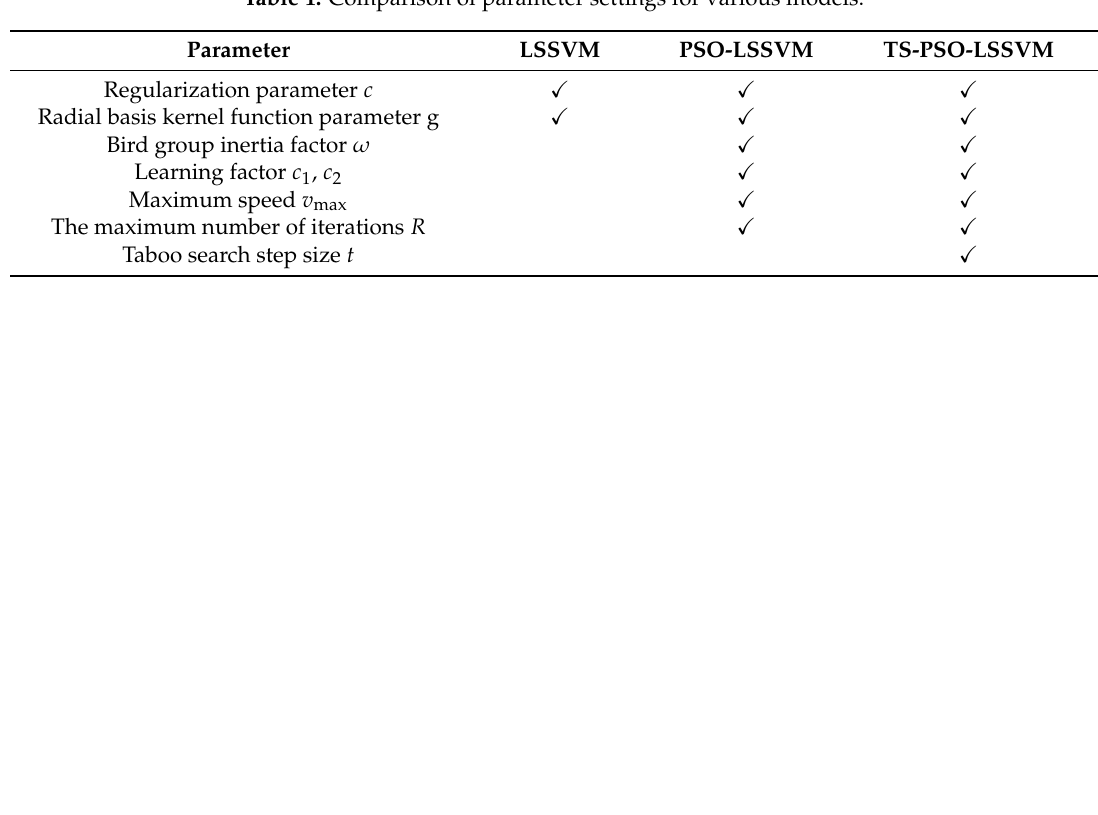
Table 1. Comparison of parameter settings for various